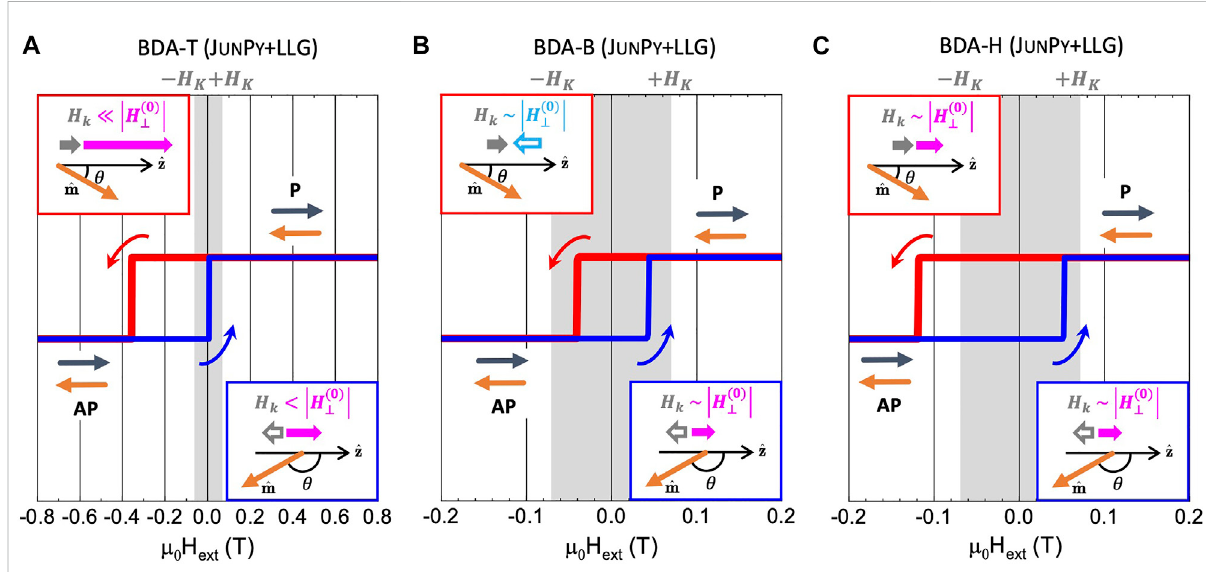
FIGURE 3 The JUNPY + LLG calculated magnetic hysteresis curves ( m z -H) for (A) BDA-T (top-site), (B) BDA-B (bridge-site), and (C) BDA-H (hollow-site) cases of amine-ended Co/BDA/Co SMMJs at zero temperature. The insets are the schematics of H ( 0 ) ⊥ and H k when θ is below and above 90 ° , where H k isthecohesive fi eldoftherightCoelectrode.Thegrayshadedarearepresentsthe fi eldregionbetween± μ threshold fi elds required for P-to-AP (AP-to-P) magnetization switching, where P and AP denote the parallel ( θ = 0) and antiparallel ( θ = π ) magnetic con fi gurations, respectively.